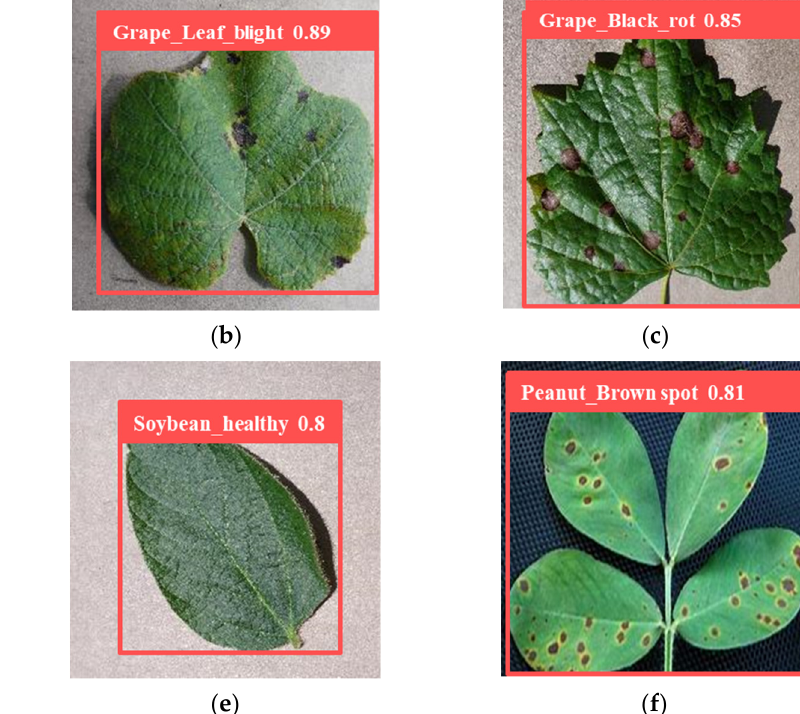
Figure 13. Partial example images of the recognition results of the improved YOLOv5 model (category name and confidence for classification). Representing the disease type (confidence) are Apple_scab